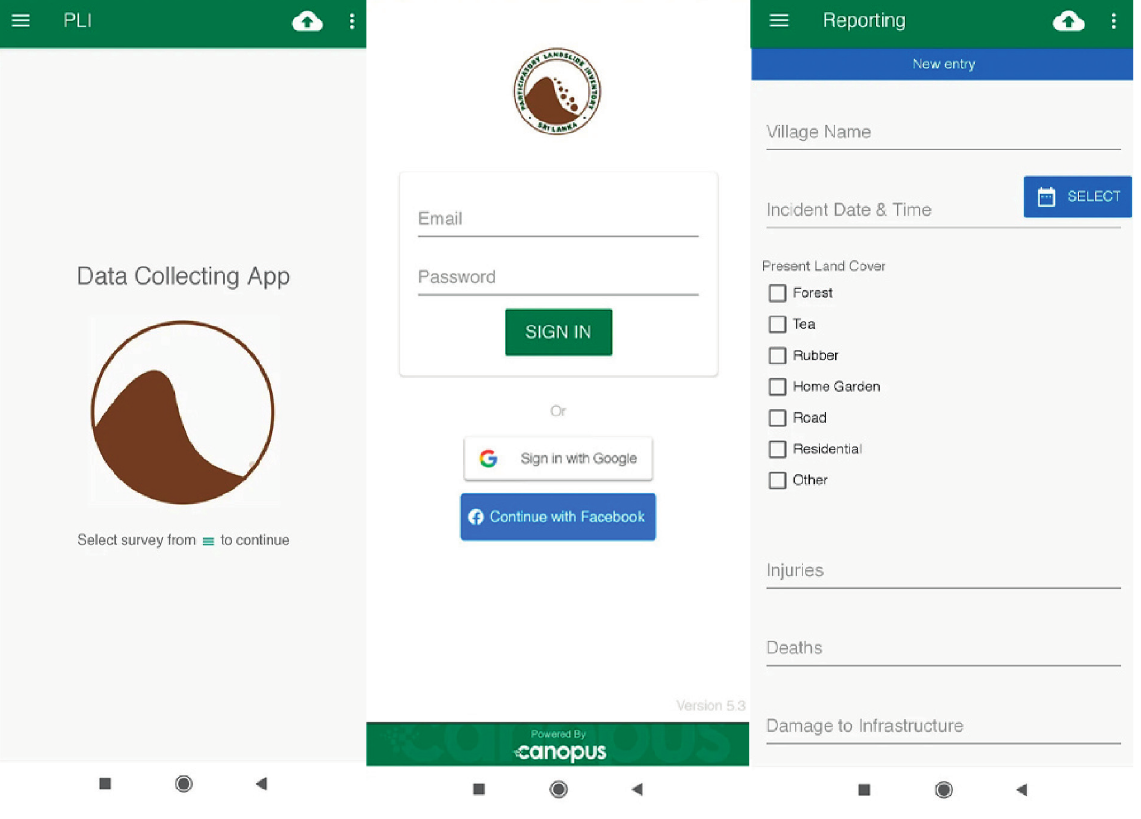
Figure 3: Interface of the PLI mobile